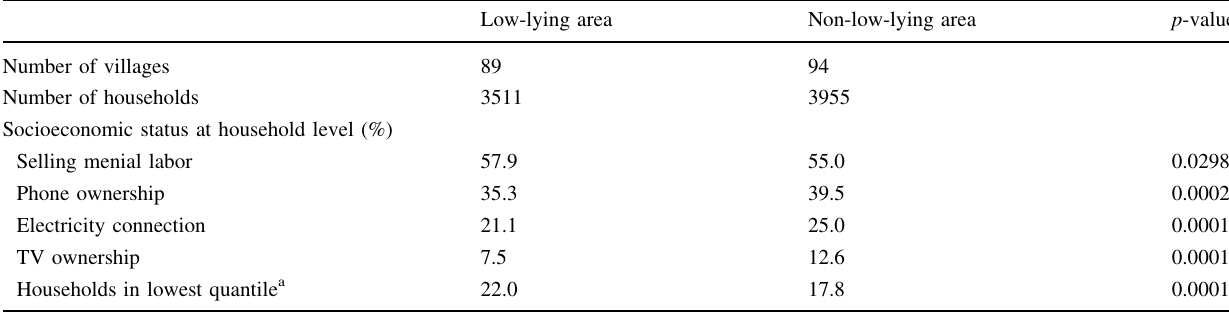
Table 1 Socioeconomic status of the low-lying and non-low-lying areas of the unions in the Chakaria Health and Demographic Surveillance System (CHDSS) in Chakaria Upazila, Bangladesh. Source Adapted from Hanifi et al. (2010) Low-lying